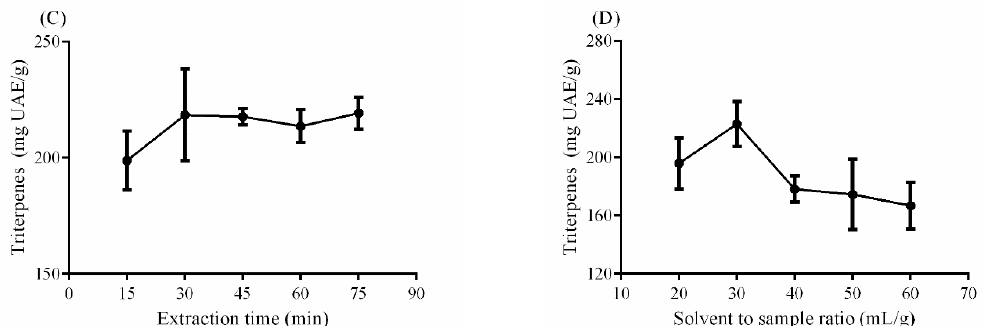
Figure 1. The effects of single factors on the yield of triterpenes. ( A ) ultrasonic power; ( B ) concentration of ethanol; ( C ) extraction time; ( D ) solvent to sample ratio.